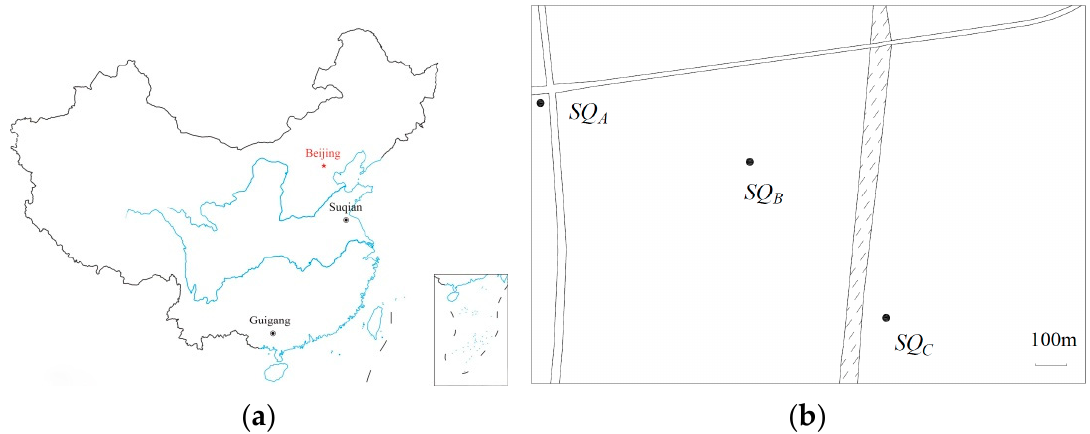
Figure 2. ( a ) Map of China and the direction of Suqian and Guigang; ( b ) Detailed sampling sites distribution at Suqian ( SQ ).